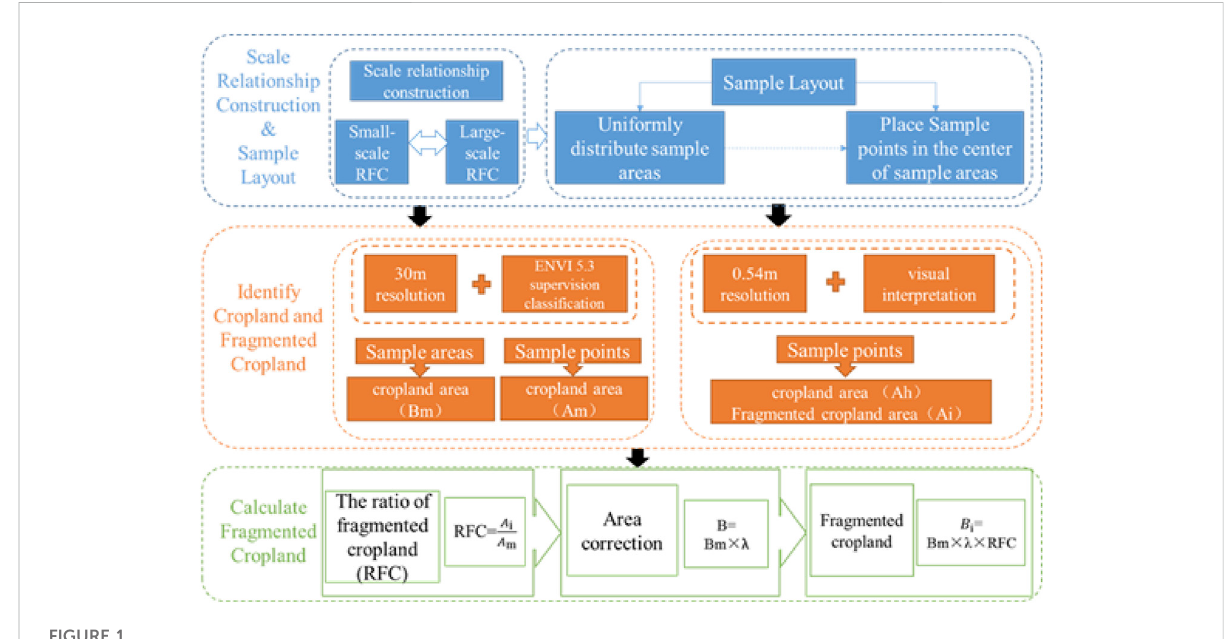
FIGURE 1 Research method framework.